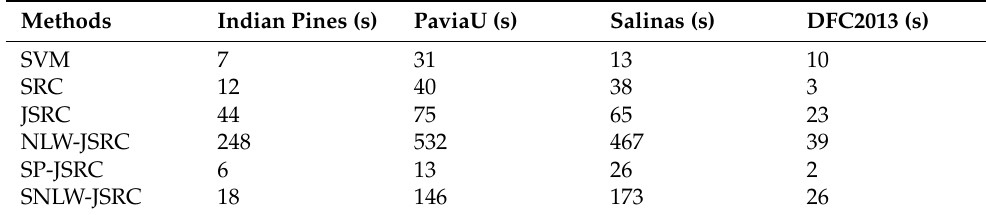
Table 9. CPU times of compared